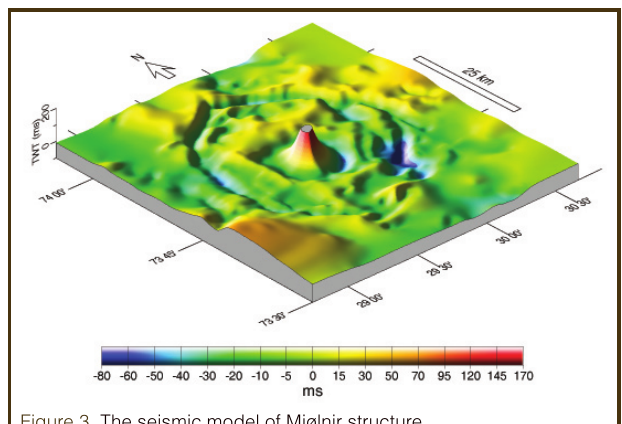
Figure 3. The seismic model of Mjølnir